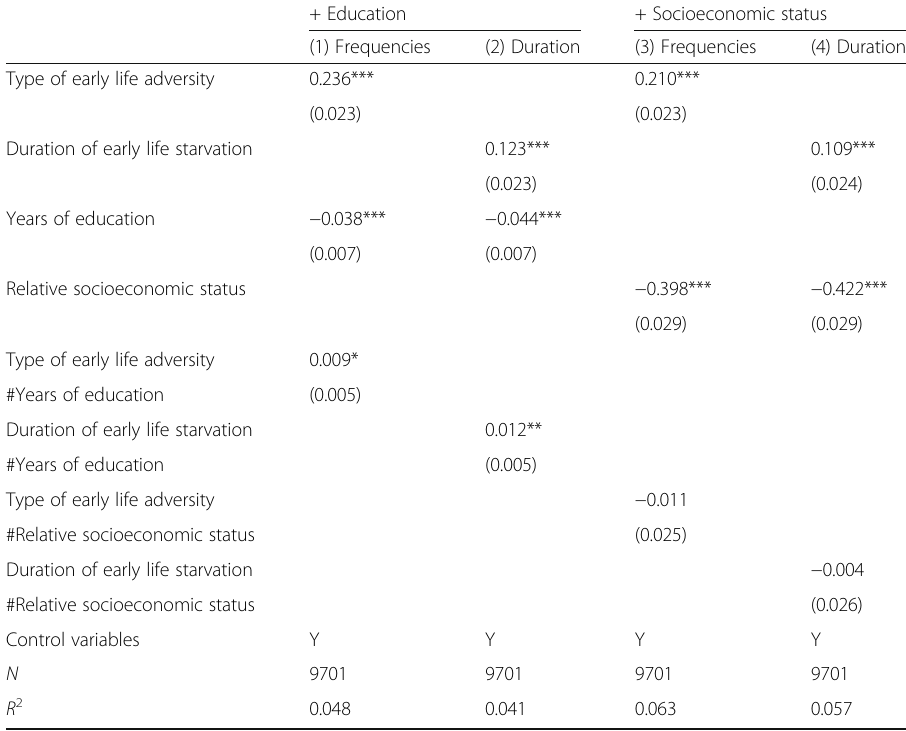
Table 6 Moderating effects of education and socioeconomic status on the health effects of early life